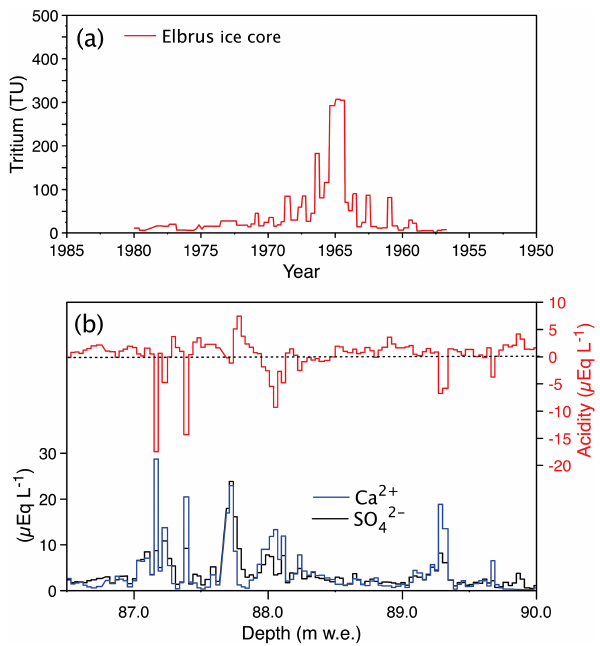
Figure 10. Absolute time horizons: (a) tritium measurements made on Elbrus ice-core samples (data were converted to 2009 with regard to the half-life time of tritium, T 1 / 2 = 12 . 32 year). The dates reported in the tritium curve are derived from the ammonium stratigraphy. (b) Calculated acidity (top; see Sect. 3.3.1), and cal- cium and sulfate (bottom) in ice layers located between 86.5 and 90mw . e.